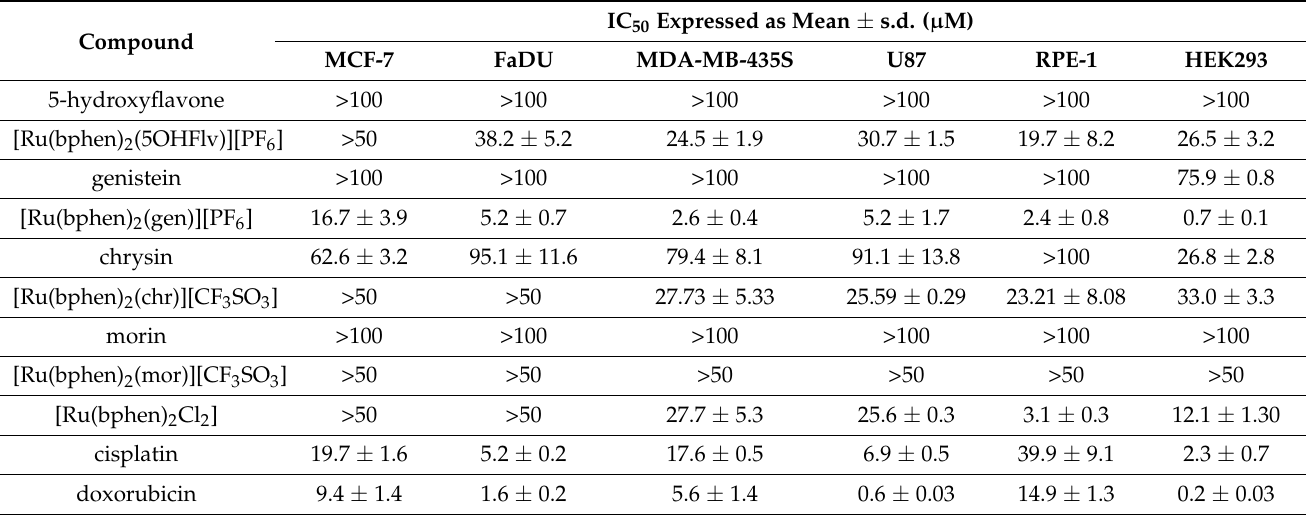
Table 2. Cytotoxicity of flavonoids and their ruthenium bis -bathophenanthroline complexes against breast cancer, pharynx carcinoma, glioblastoma, immortalised retinal pigmented epithelium, and immortalised embryonic kidney cell lines. IC 50 Expressed as Mean ± s.d. ( µ Compound